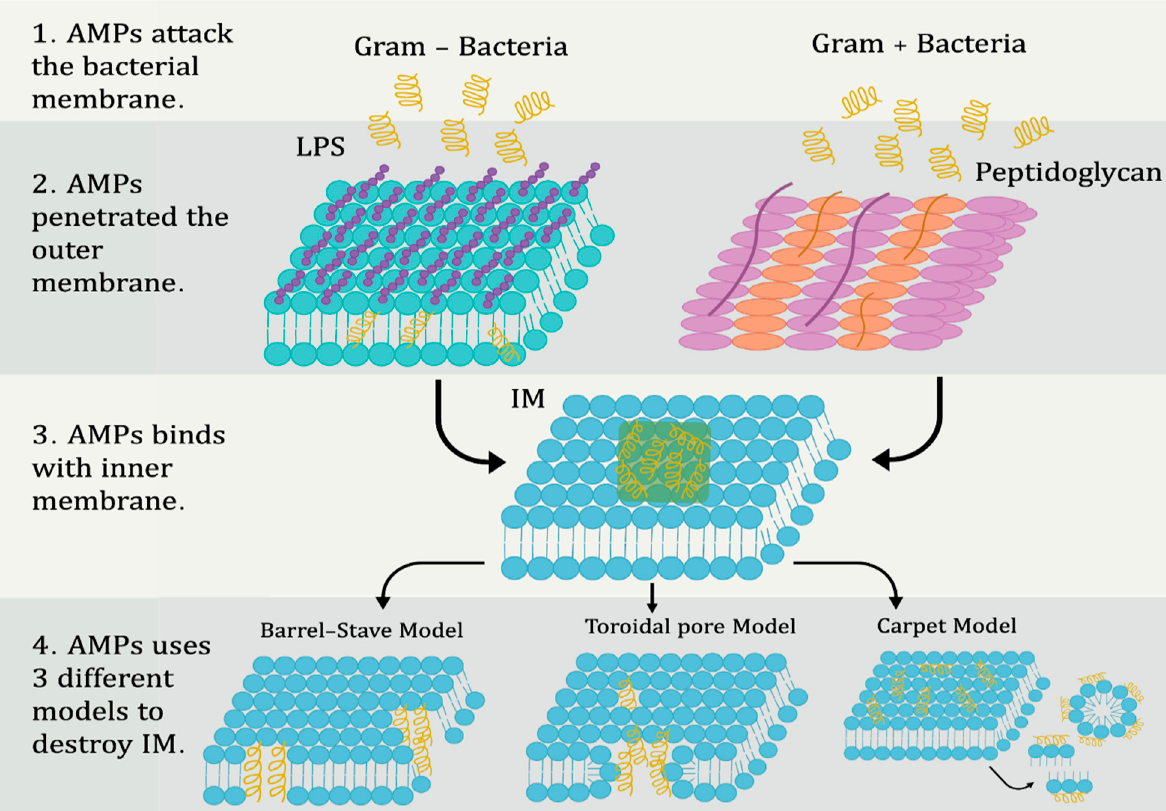
Figure 4. Mechanism of AMPs in membrane targeting.